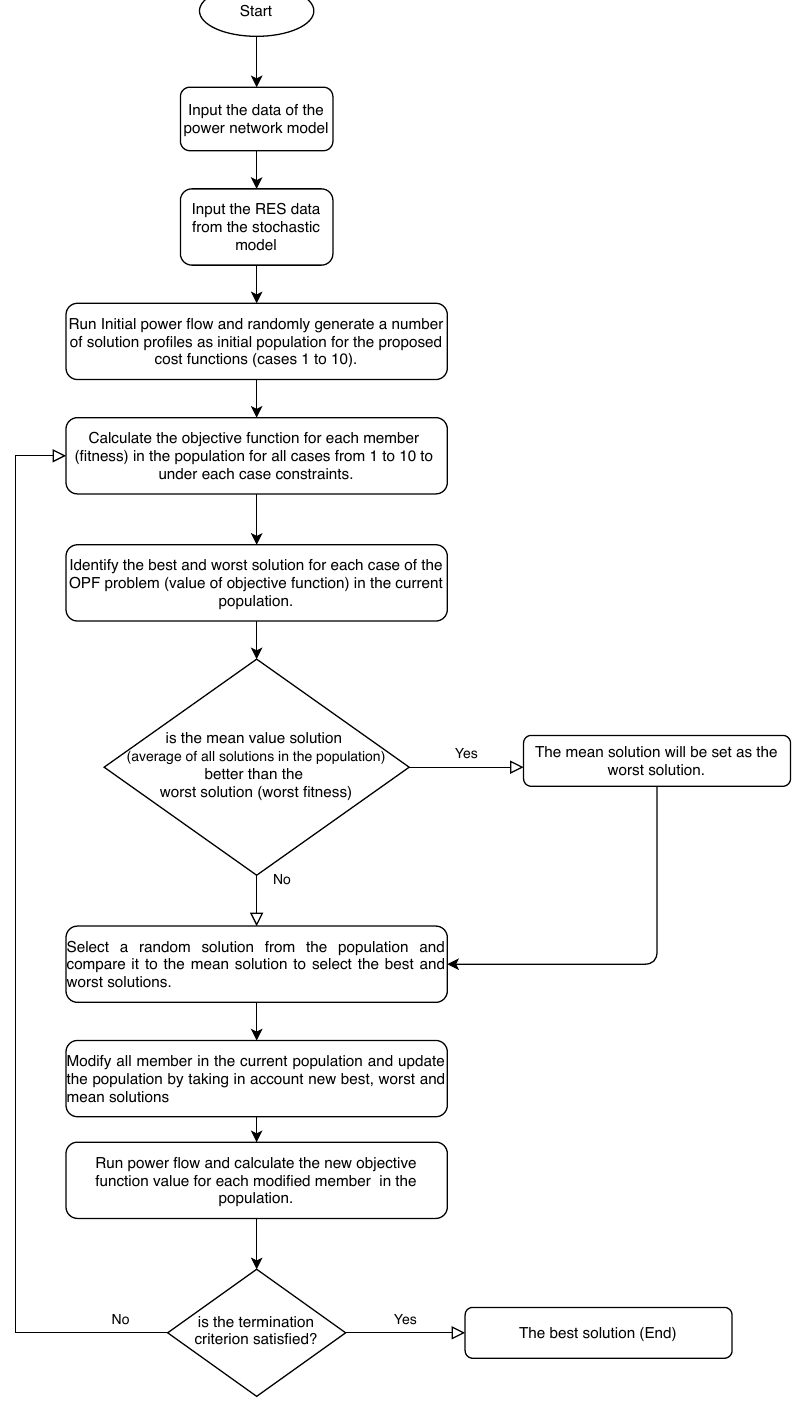
Figure 1. Flowchart of the proposed GROM to solve the OPF